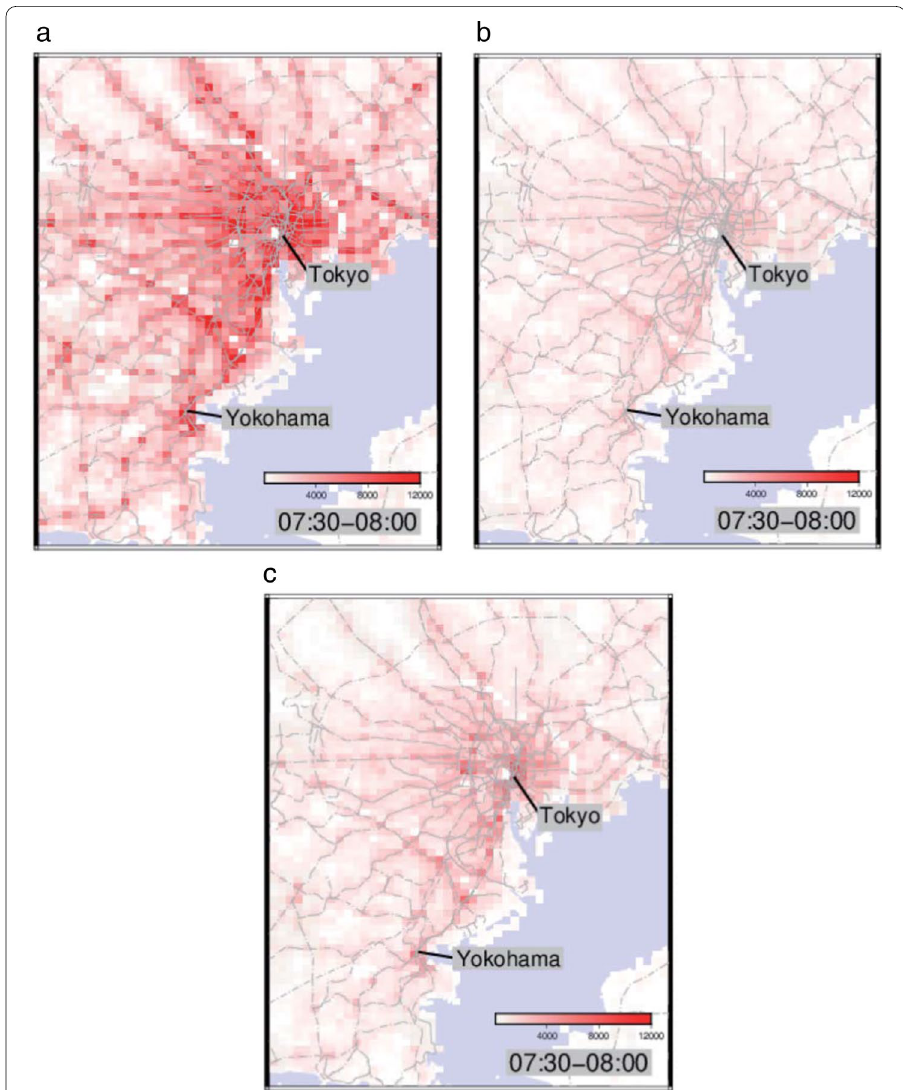
Fig. 1 The population distribution of moving people in the morning around the Tokyo metropolitan area. a – c , Population distribution maps of moving people in the morning on weekdays in January ( a ), May ( b ), and October ( c ), where the predicted population is normalized to the actual population in Japan with color strength proportional to the number of moving people in the square. The total number of moving people in the morning (07:30–08:00) is 9,000,000 (January), 2,500,000 (May), 3,300,000 (October) in the Tokyo metropolitan area, whose population is 35,000,000 (Tokyo, Kanagawa, Saitama, Chiba). The gray lines in the map represent the